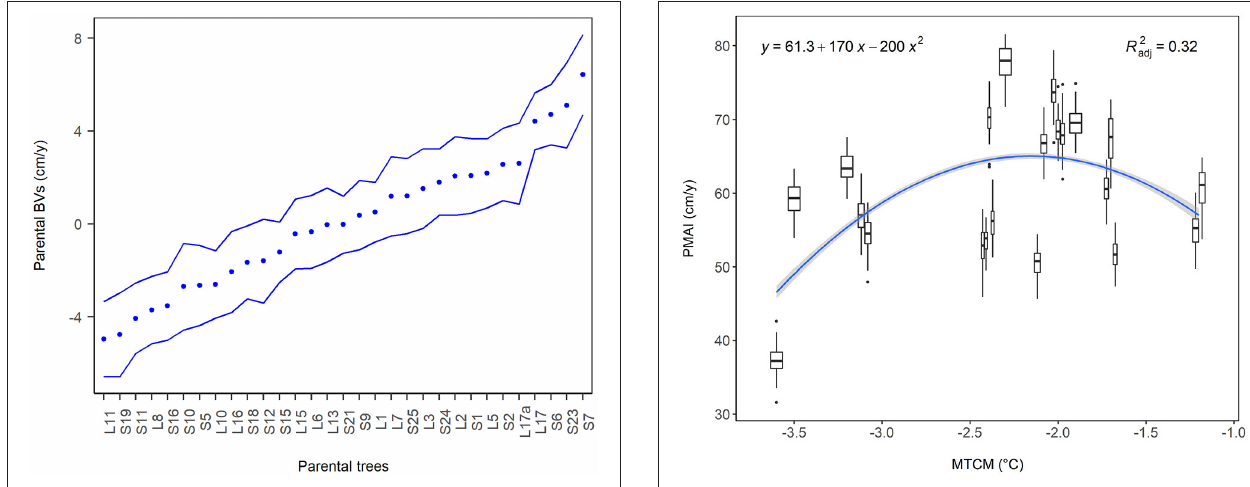
FIGURE 2 | Parental trees are sorted by additive genetic values. The BVs (dots) are expressed in the units of measurement (cm/year). 95% approximate confidence intervals (dashed line) were calculated as two times the standard errors.